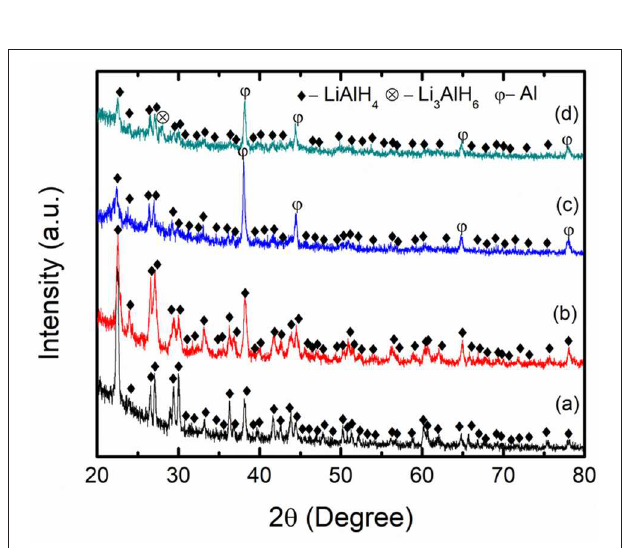
FIGURE 7 | XRD patterns of (a) as-received LiAlH 4 , (b) as-milled LiAlH 4 , (c) LiAlH 4 + 10 wt.% K 2 NbF 7 , and (d) LiAlH 4 + 30 wt.% K 2 NbF 7 .